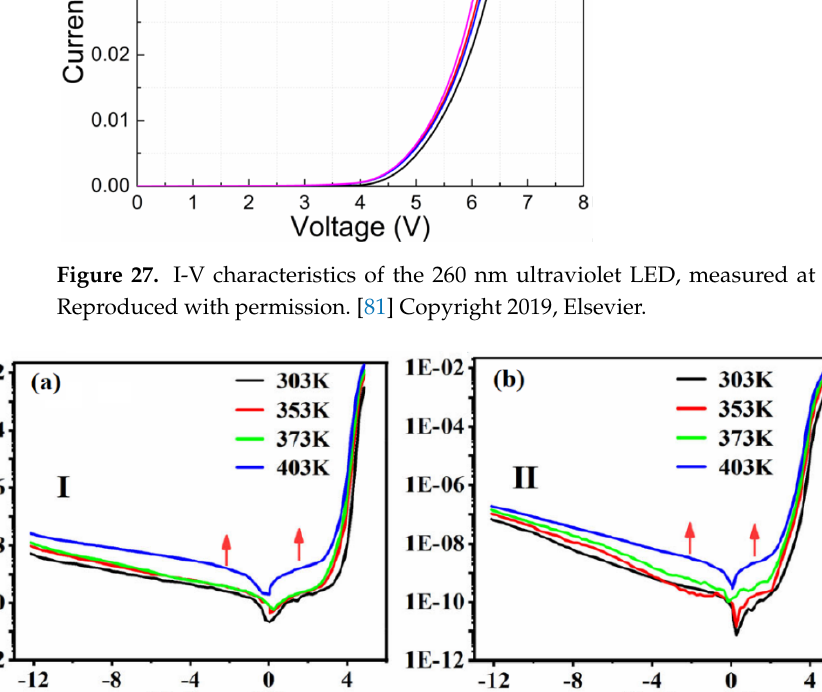
Figure 27. I-V characteristics of the 260 nm ultraviolet LED, measured at different stress times. Re- produced with permission. [81] Copyright 2019, Elsevier.